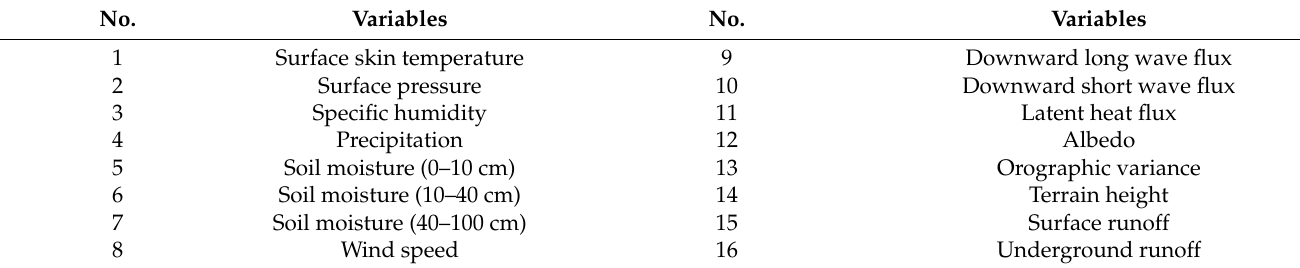
Table 2. WRF downscaled variables used as the CNN-LSTM model